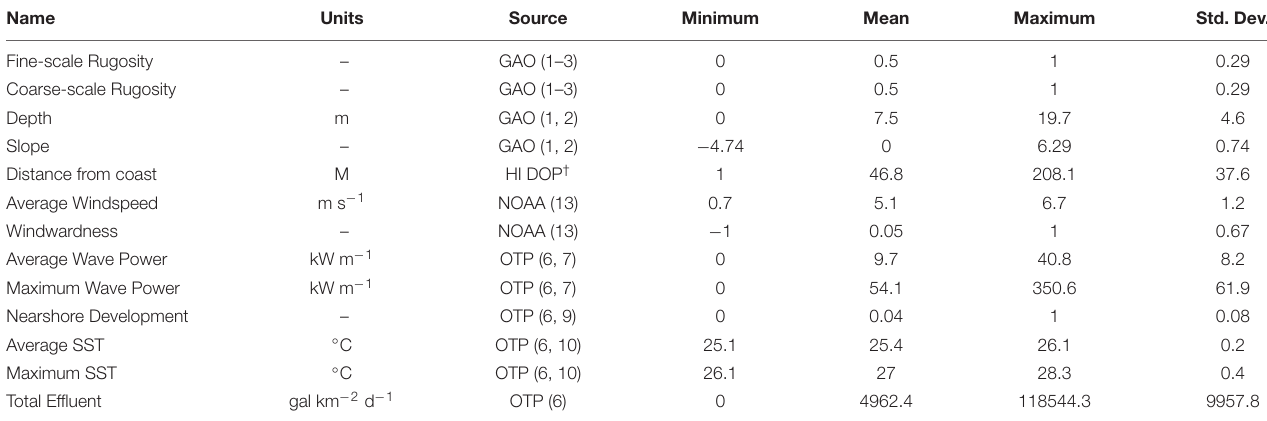
TABLE 1 | Summary statistics for the two mapped rugosity scales as well as 11 factors used in the land-sea driver modeling assessment. Name